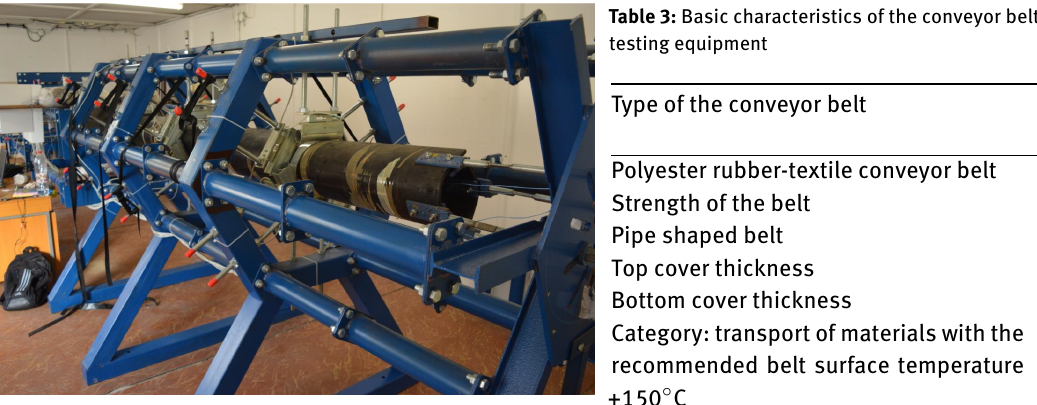
Figure 2: Physical model of a pipe conveyor